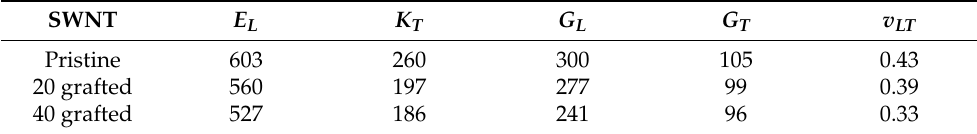
Table 2. Transversely isotropic elastic constants of SWNTs [GPa].